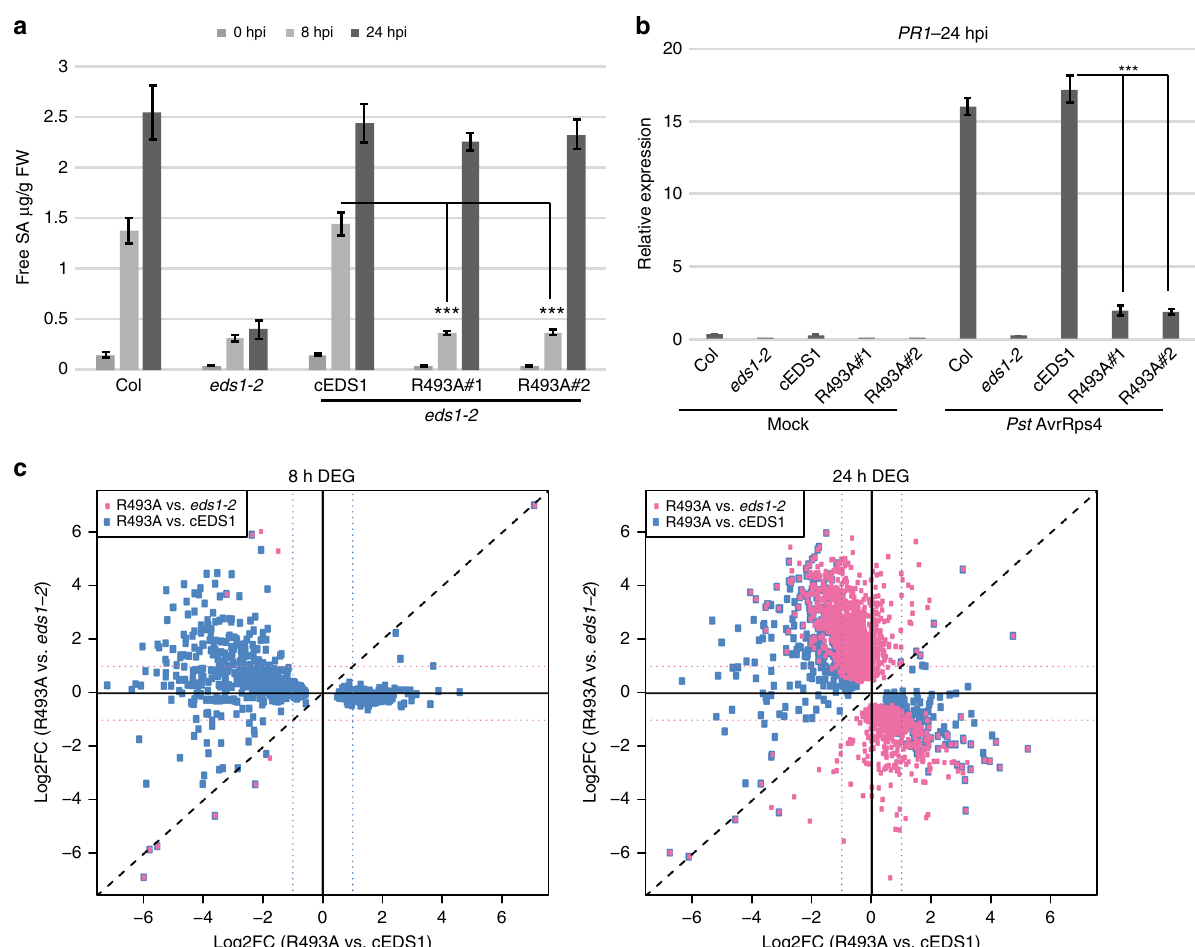
Fig. 2 EDS1 R493A delays TNL transcriptional reprogramming. a Four-week-old plants were in fi ltrated with Pst AvrRps4 (OD 600 – 0.005) and free SA was quanti fi ed at 0, 8 and 24 hpi. Bars represent means± SE of four biological replicates. Differences between genotypes were analysed using t-test (Bonferroni corrected, p < 0.05). Similar results were obtained in two independent experiments. b Four-week-old plants were in fi ltrated with 10 mM MgCl 2 (mock) or Pst AvrRps4 (OD – 0.005), and leaf samples collected at 24 hpi. PR1 transcripts were measured using qRT-PCR and normalised to GapDH . Bars represent 600 means ± SE of three biological replicates. Differences between genotypes were analysed using t -test (Bonferroni corrected, p < 0.05). c A 2-D scatter plot comparing R493A#1 vs. eds1-2 and R493A#1 vs. cEDS1 at 8 and 24 hpi with Pst AvrRps4 . Plots depict differentially expressed genes (DEG) between R493A vs. eds1-2 (pink dots) and R493A vs. cEDS1 (blue dots). DEG represented were fi ltered with a |log 2 FC| ≥ 1, FDR ≤